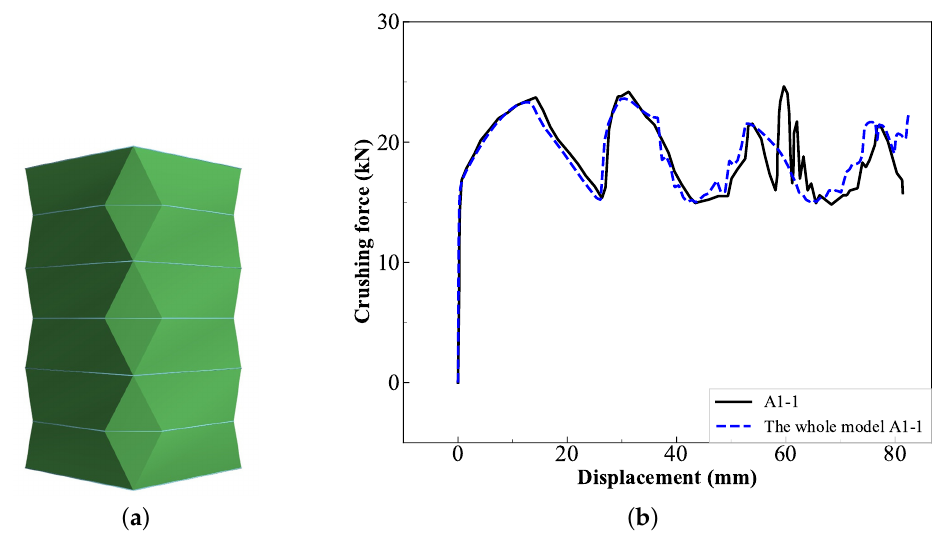
Figure 7. Numerical model verification comparison: ( a ) A1-1 [17] origami tube model; ( b ) comparison of crushing force and displacement curve: the solid line is model A1-1, and the dotted line is the whole model A1-1, which was simulated by the method in the